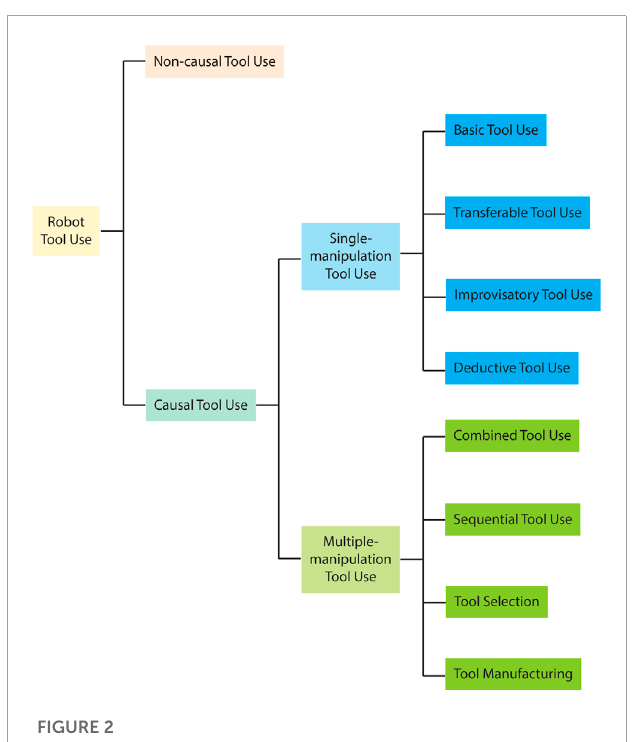
FIGURE 2 Tool use